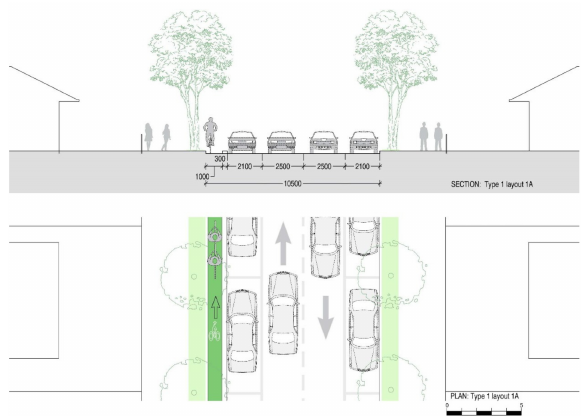
Figure 4. Section and plan drawings showing proposed retrofit ‘Design 1A’ for a reconfigured ‘Type 1’ street including a 1 m single cycling lane and 0.3 m wide physical barrier with similar roadway, but 2.1 m parking lanes on either side of the streets and two-way single traffic lanes of 2.5 m width to accommodate 40 km/h speed